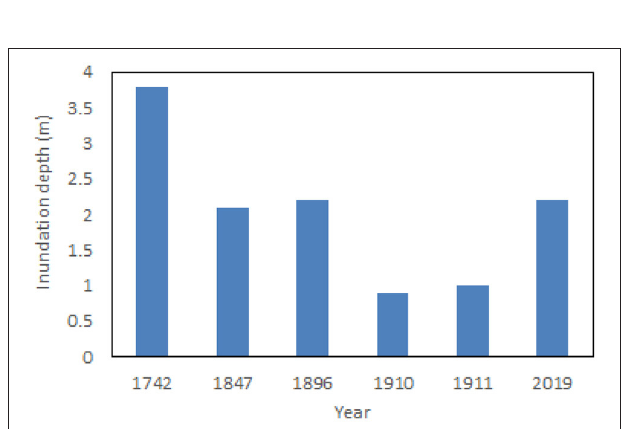
FIGURE 3 | Inundation depths at the same site in different flood